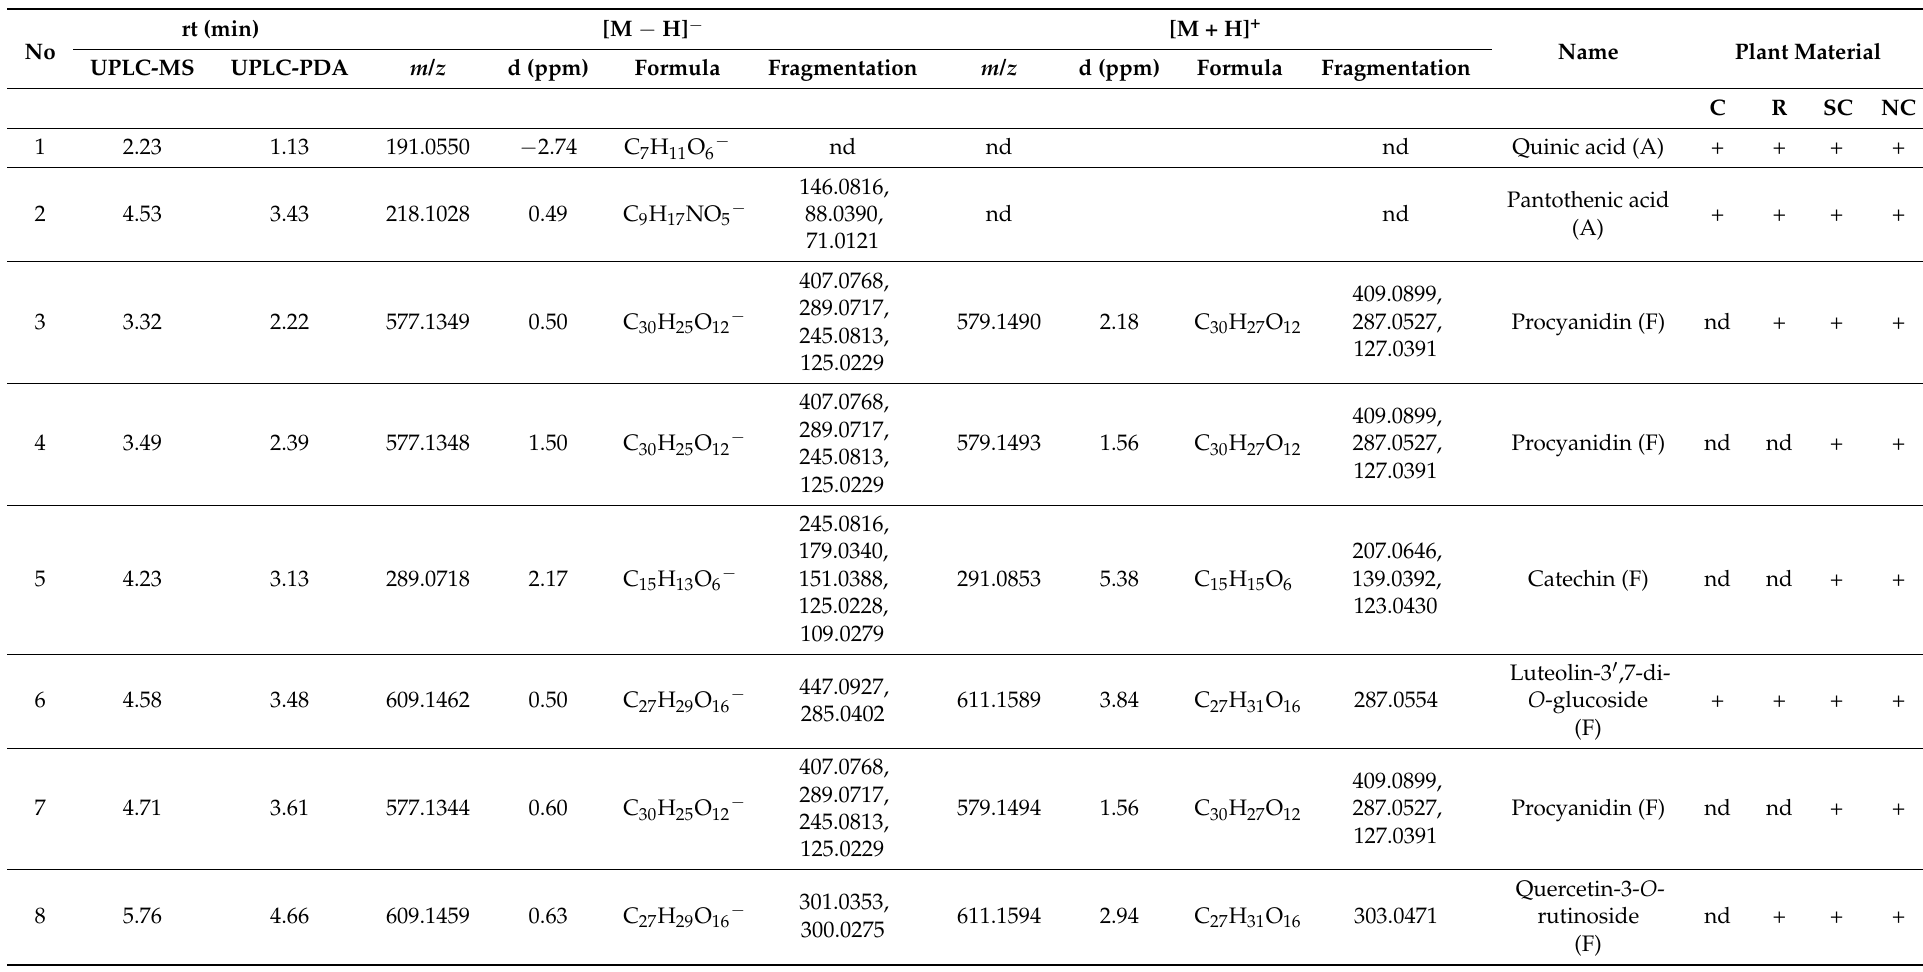
Table 8. Secondary metabolites identified in plant biomass of Linnaea borealis var. borealis (leafy shoots from natural sites (NS); shoot cultures (SC); roots from micropropagated plantlets (R); biomass from callus cultures